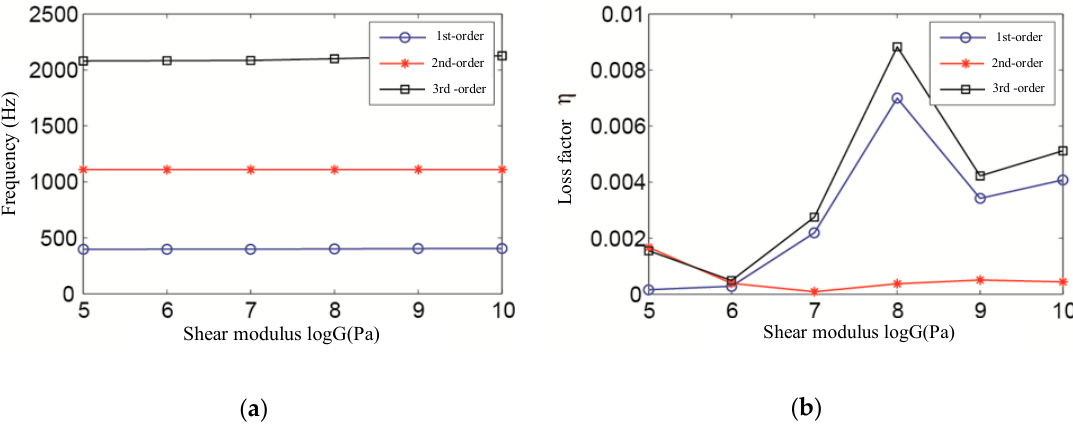
Figure 14. Influence of shear modulus of viscoelastic layer on ( a ) modal frequency and ( b ) loss factor.